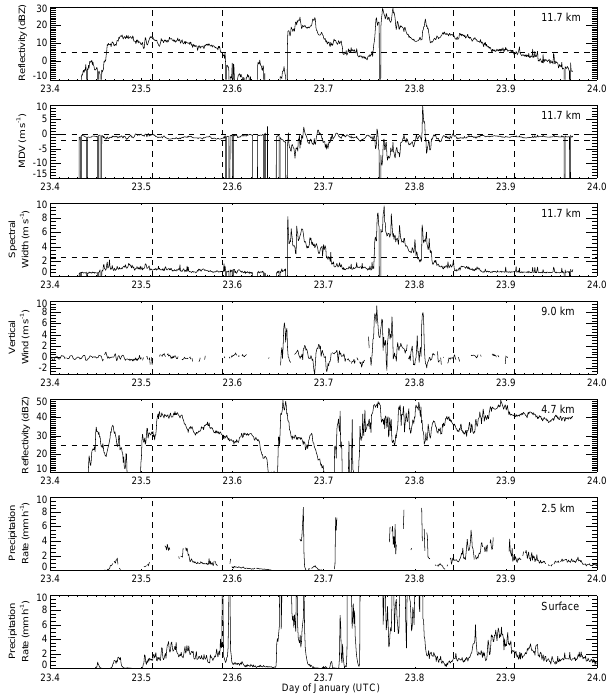
Figure 9. Time series of observations and retrievals from co-located S-band, UHF, and VHF profilers on 23 January 2006: radar reflec- tivity ( Z e ), mean Doppler velocity (MDV; negative downward), and Doppler velocity spectral width at 11.7km; retrieved vertical wind speed at 9km; Z e just below the melting level at 4.7km; retrieved precipitation rate at 2.5km; and precipitation rate measured at the surface. Vertical dashed lines indicate stratiform rain periods as in Fig. 8. 23.512-23.588